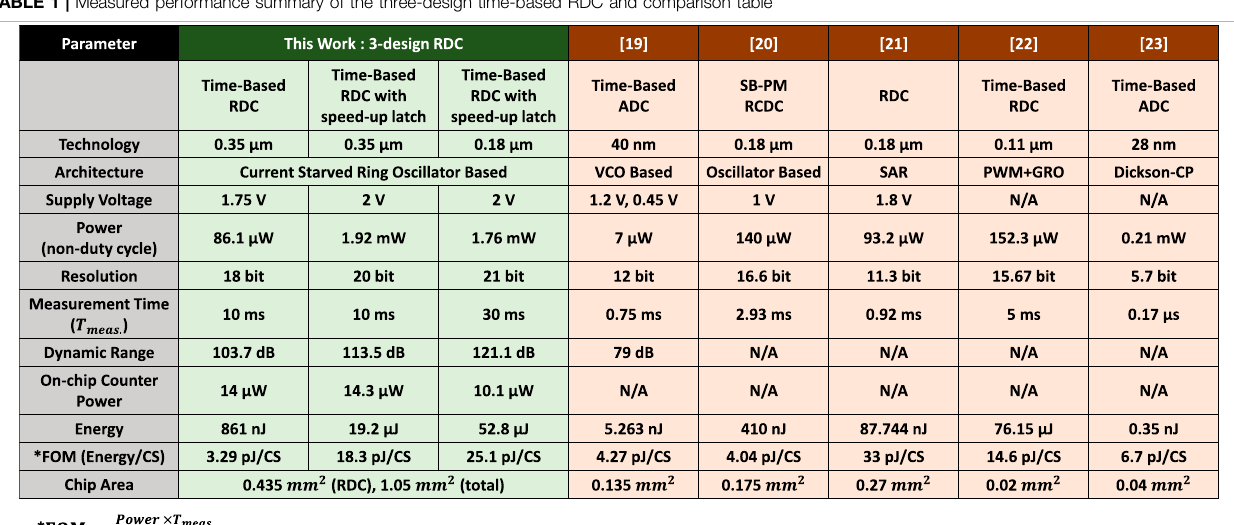
Frontiers in Electronics |